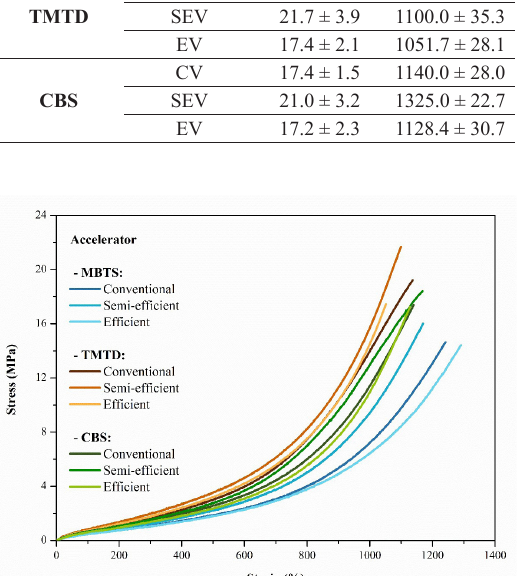
Figure 1. Stress vs. strain curves of NR compounds vulcanized and accelerated by: MBTS, TMTD and CBS in their respective vulcanization systems.